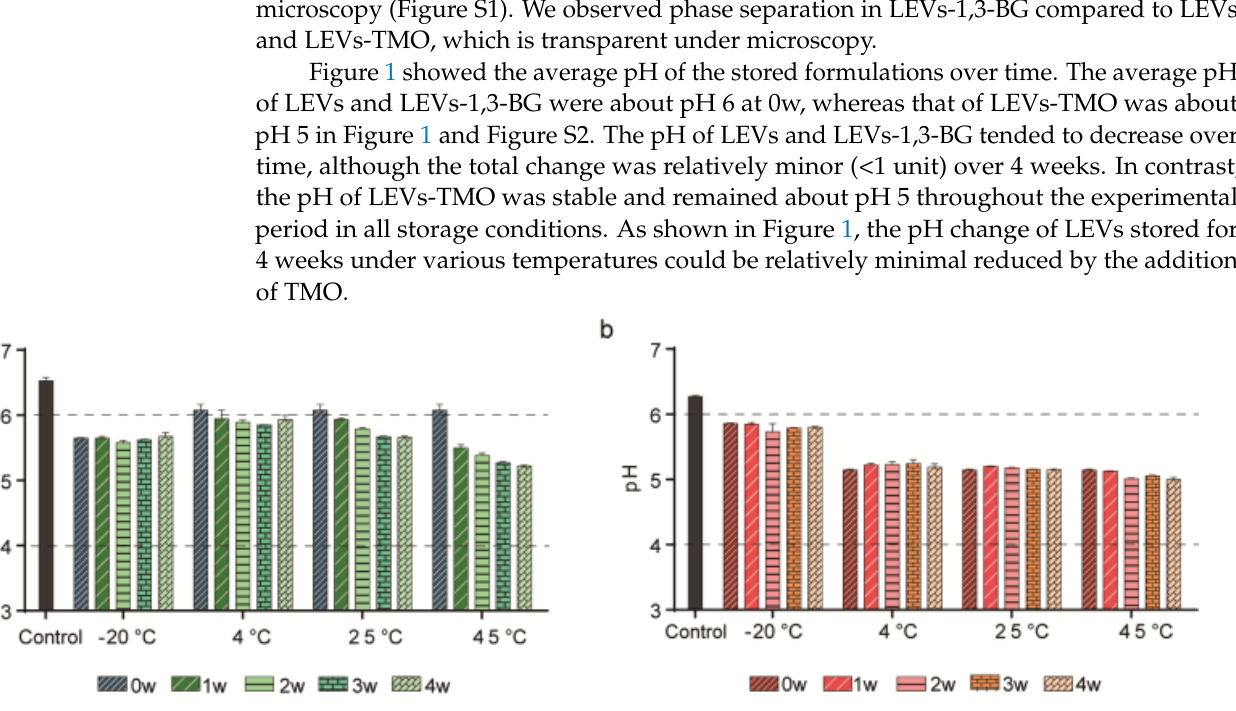
Figure 1. pH values for LEVs stored with and without preservatives at different temperatures. pH values for ( a ) LEVs and ( b ) LEVs-TMO following storage for 4 weeks at − 20, 4, 25, and 45 °C. Data are presented as mean ± standard error of mean (SEM).